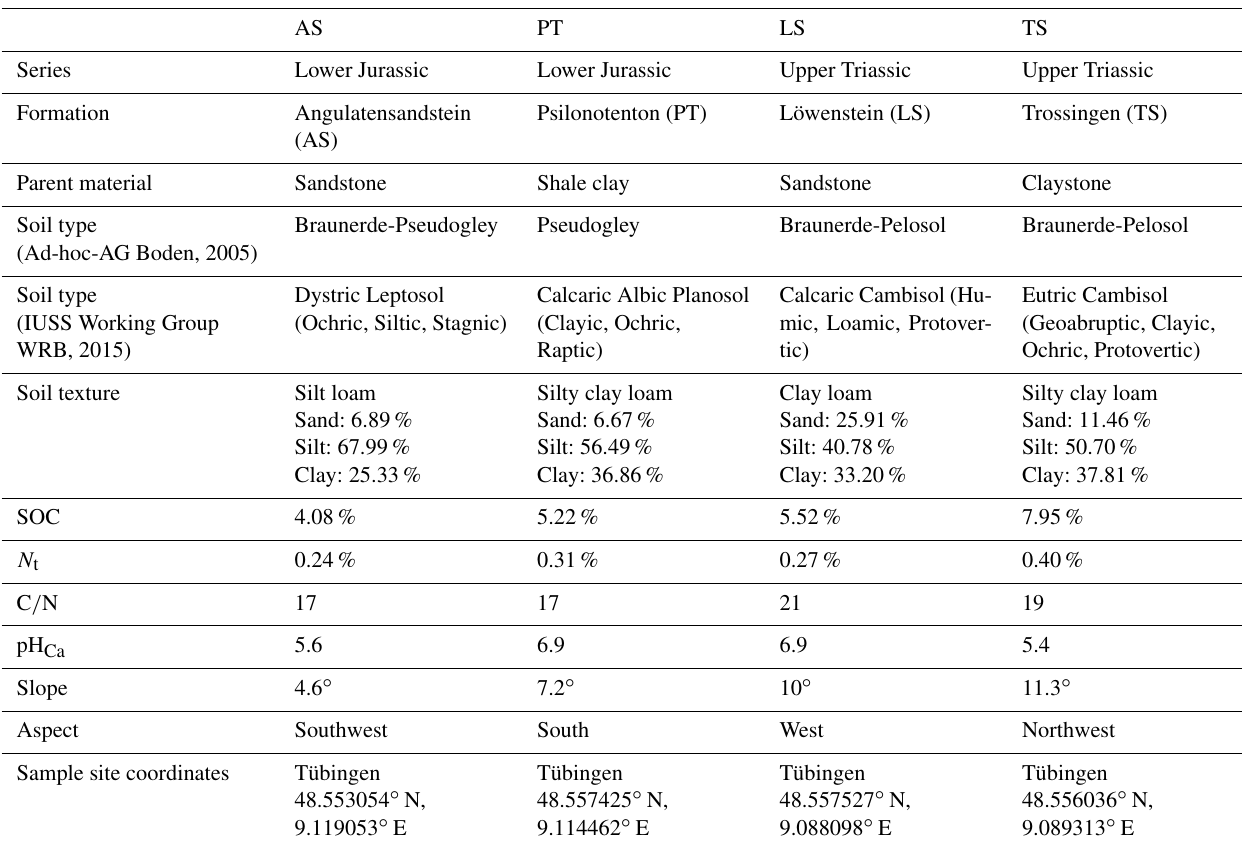
Table A1. Characteristics of studied skid